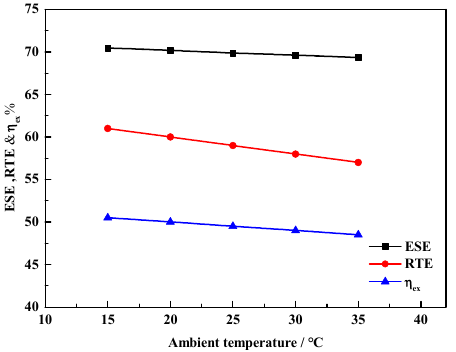
Figure 6. Effect of ambient temperature on ESE, RTE, and η ex .